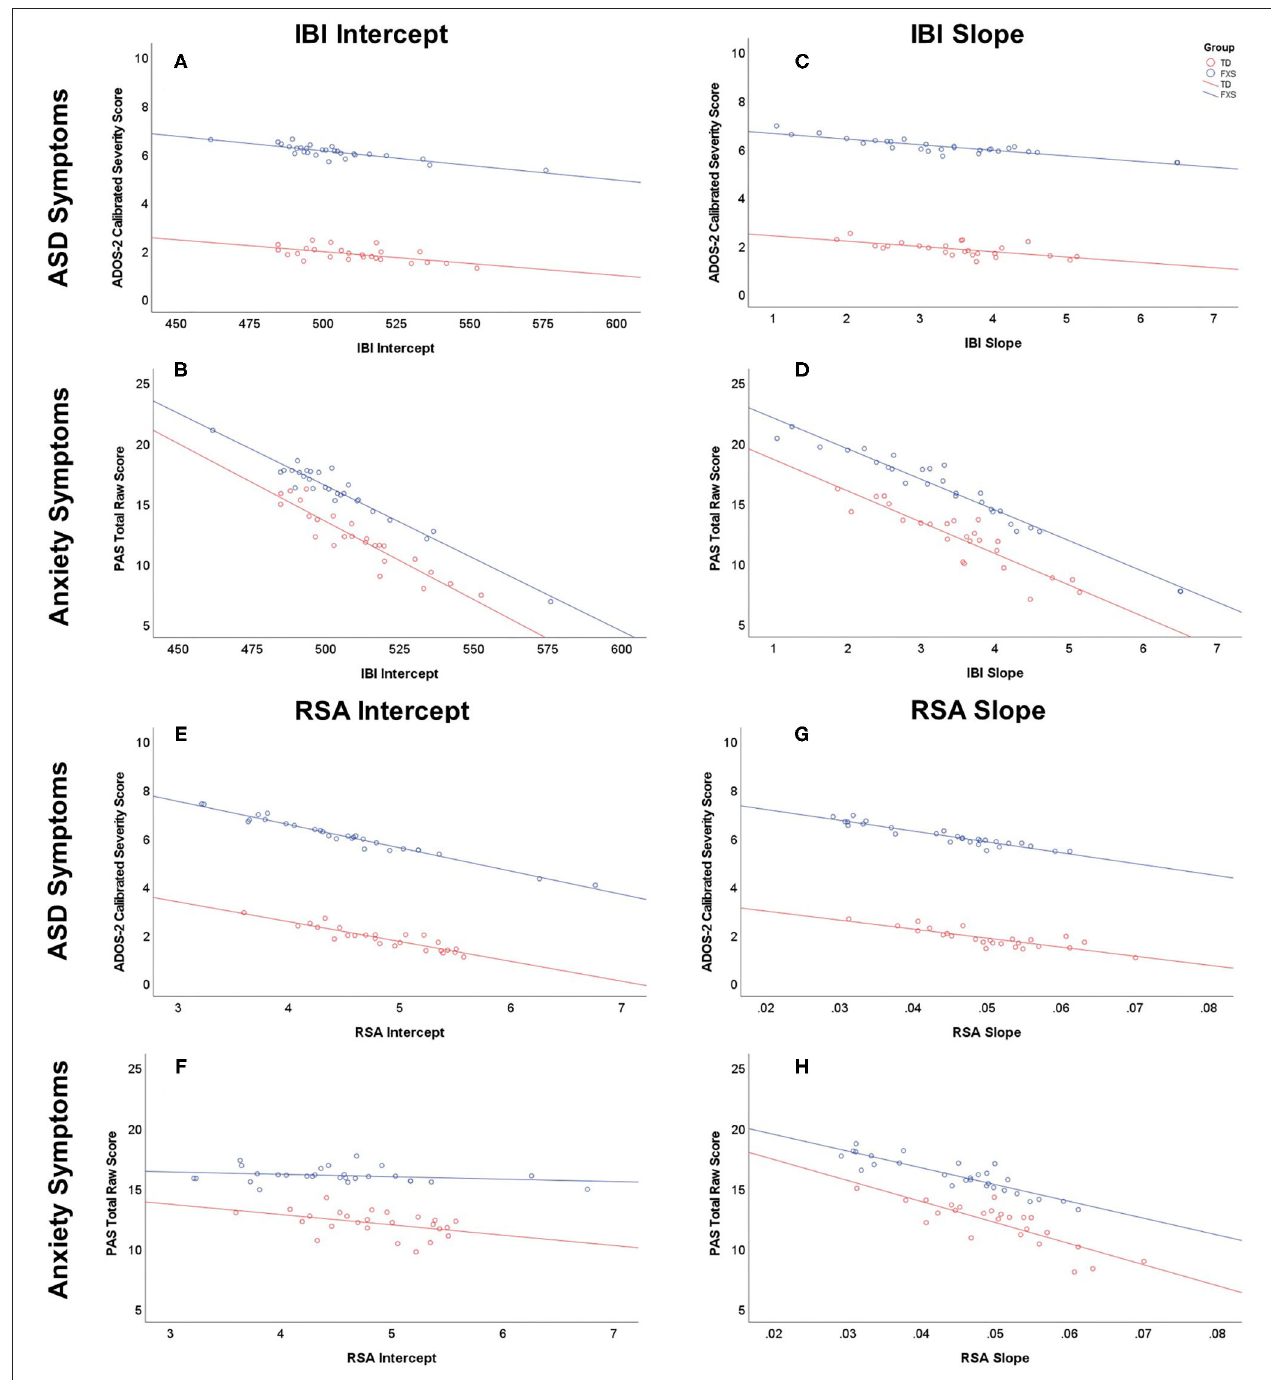
FIGURE 3 | Relationship between IBI and RSA at 24 months of age and ASD and anxiety symptoms at 36 months of age or older (predicted values). Males with FXS are indicated in blue; TD males are indicated in red. IBI intercept predicting ASD and anxiety symptoms is depicted in (A) and (B) , respectively. IBI slope predicting ASD and anxiety symptoms is depicted in (C) and (D) , respectively. RSA intercept predicting ASD and anxiety symptoms is depicted in (E) and (F) , respectively. RSA slope predicting ASD and anxiety symptoms is depicted in (G) and (H) , respectively. anxiety symptoms, but not ASD symptoms. The relationship on the FXS phenotype, which is characterized by high rates of between early hyperarousal and later anxiety symptoms is in line both anxiety and ASD. Specifically, shorter IBI at 24 months with the theory of “autonomic inflexibility” (33, 34) and empirical and slower change in IBI across development predicted higher